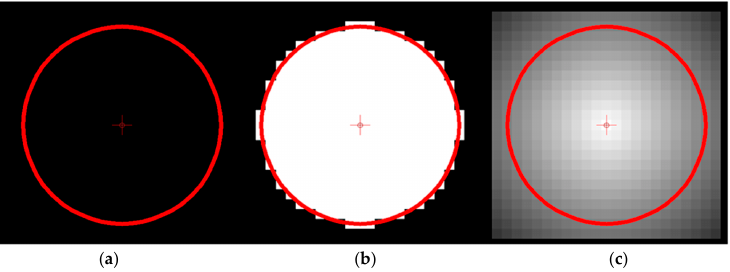
Figure 1. The approximation of a given circular contour ( a ) in a binary voxel model ( b ) allows only an inaccurate description. The use of signed distance fields ( c ) and the interpolation-based recalculation of the contour is much more accurate.